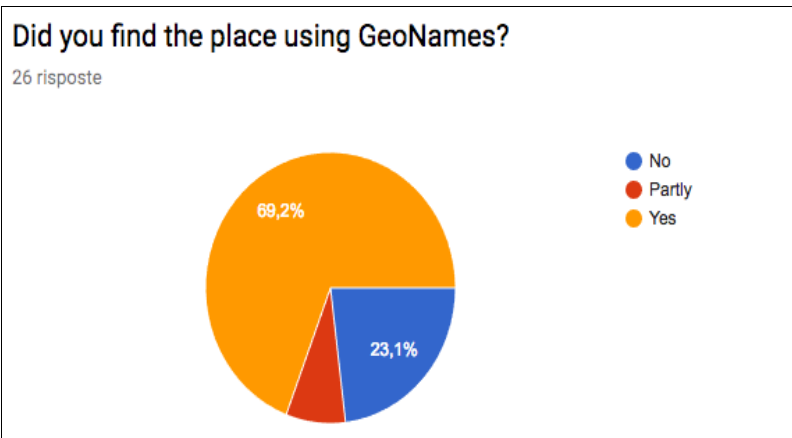
Figure 14. Information on the locations retrieved through GeoNames